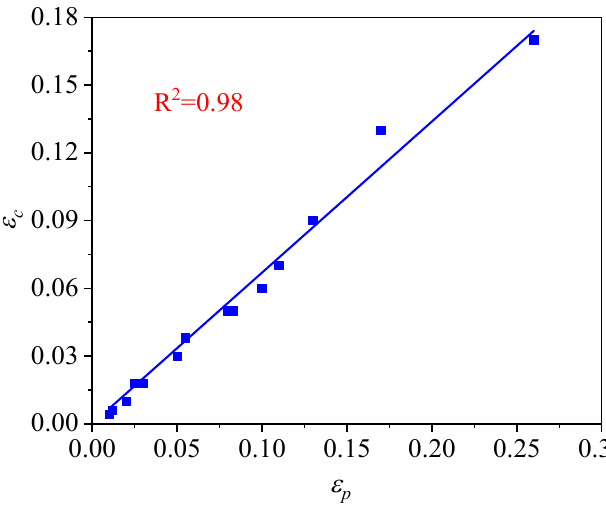
Figure 6. Relationship between the ε c and ε p